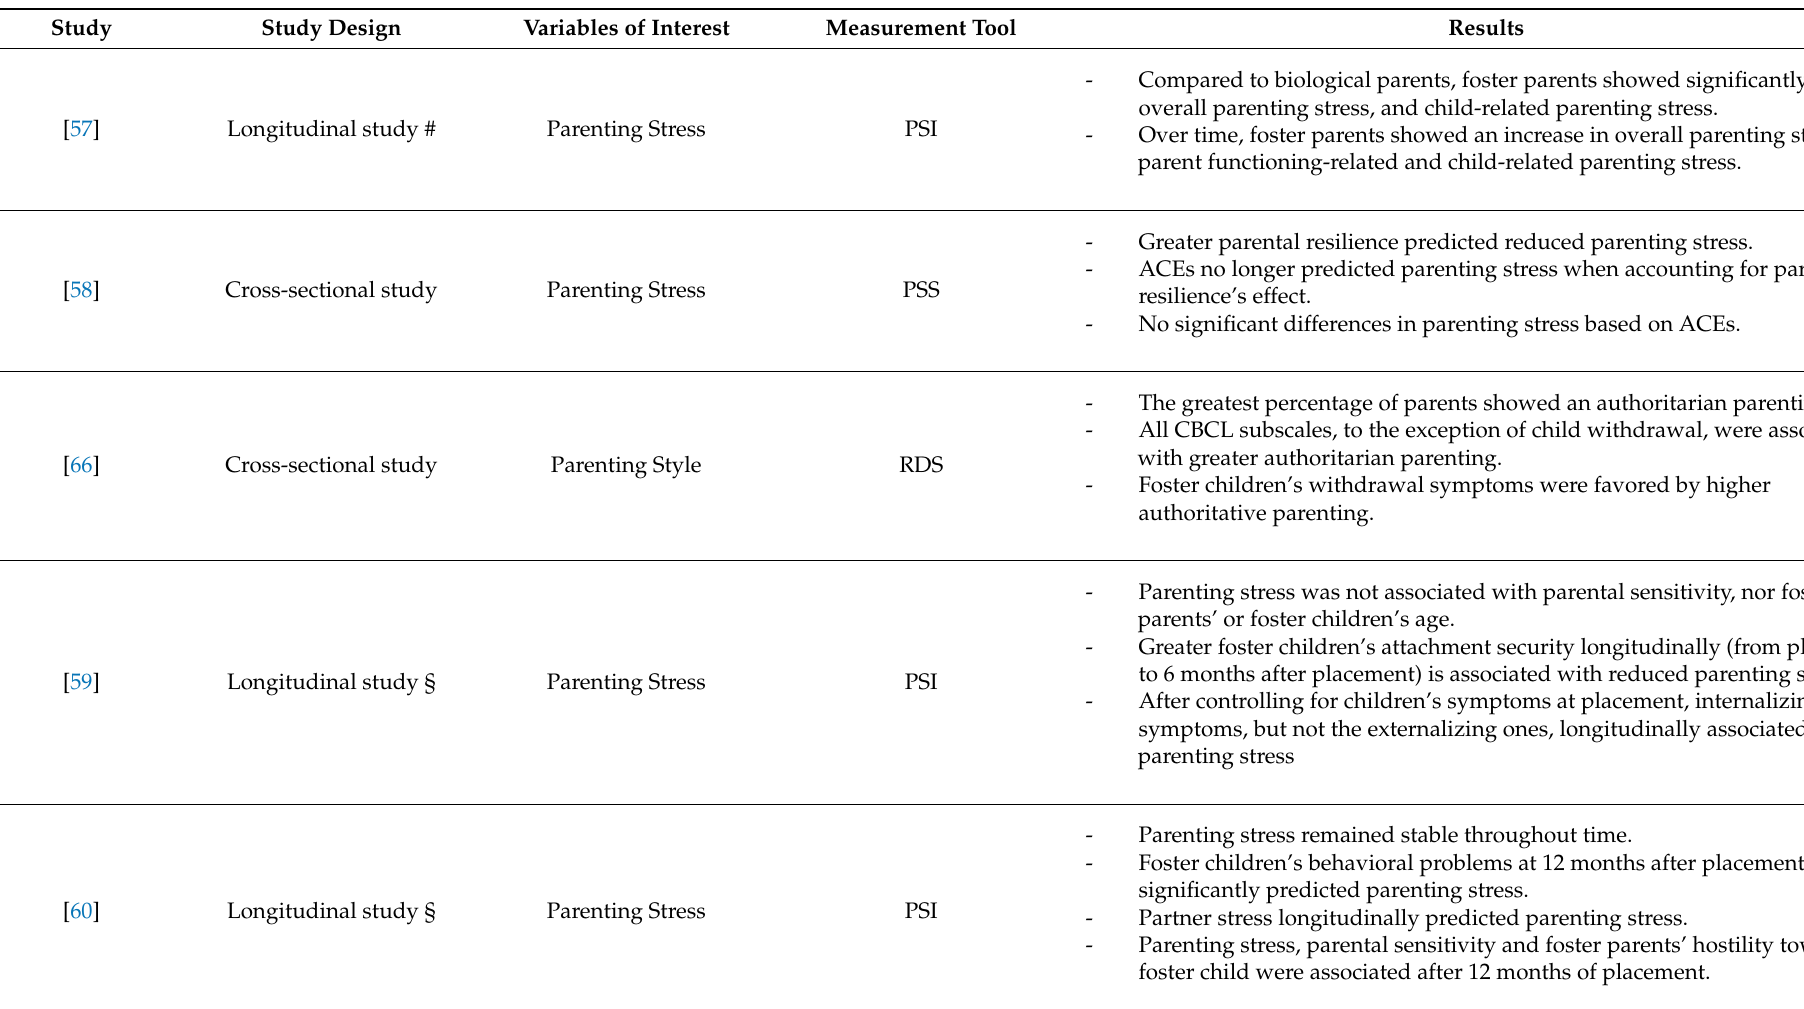
Table 2. Results